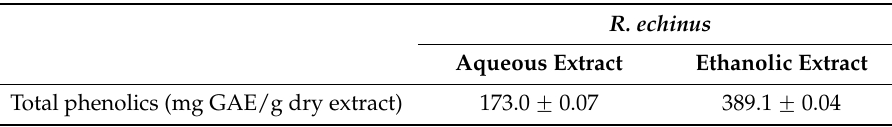
Table 3. Total phenolic content of R. echinus